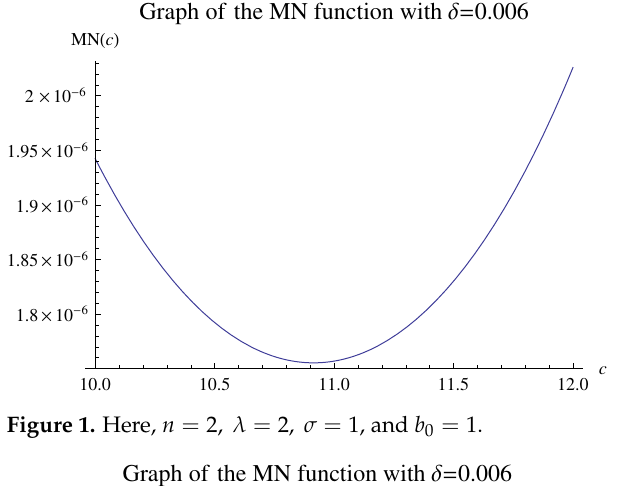
Figure 1. Here, n = 2, λ = 2, σ = 1, and b 0 = 1. Graph of the MN function with ∆= 0.006